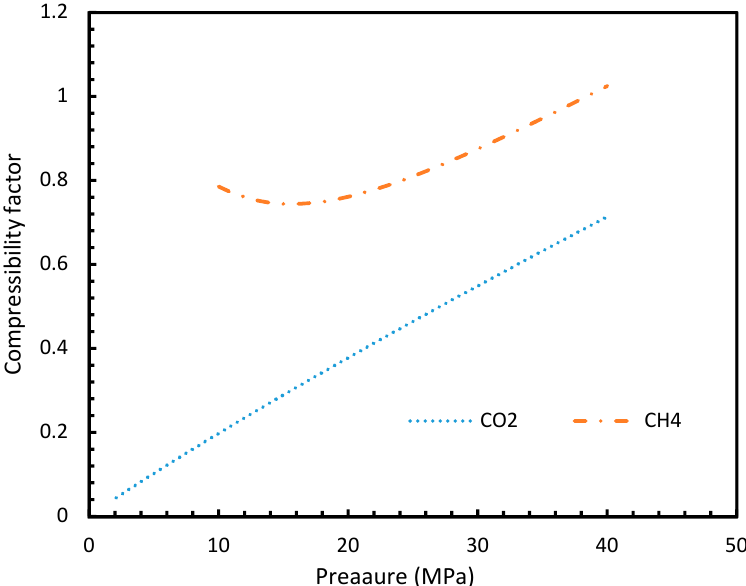
Figure 13. Compressibility factors of CO 2 and CH 4 under a range of operational